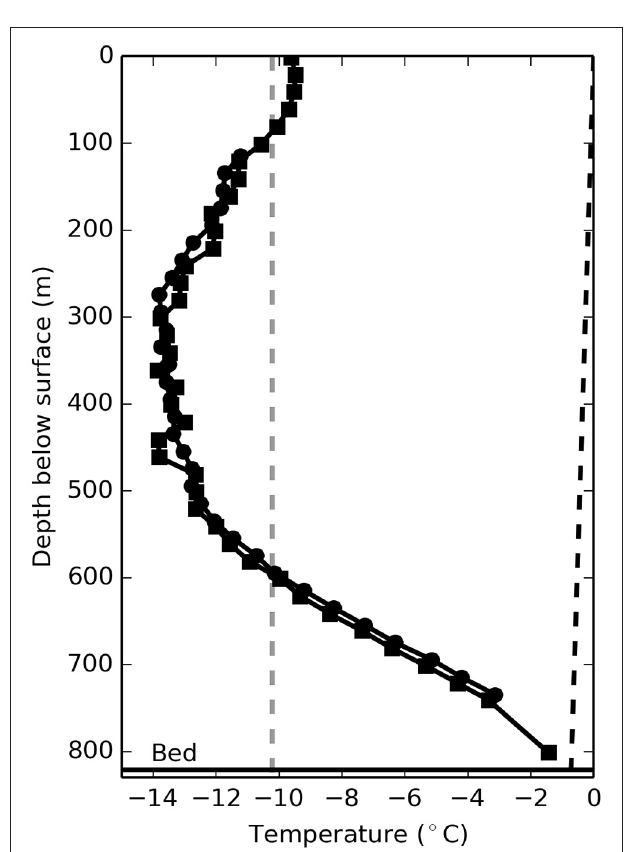
FIGURE 4 | Temperature profiles in two boreholes, < 20m apart, drilled to the ice sheet bed (Harrington et al., 2015). Dashed black line represents the pressure melting temperature, calculated using a Clausius Clapeyron slope of 8.7 × 10 − 4 ◦ C m − 1 for ice. Dashed gray line shows the average temperature of − 10.2 ◦ C, calculated from the two